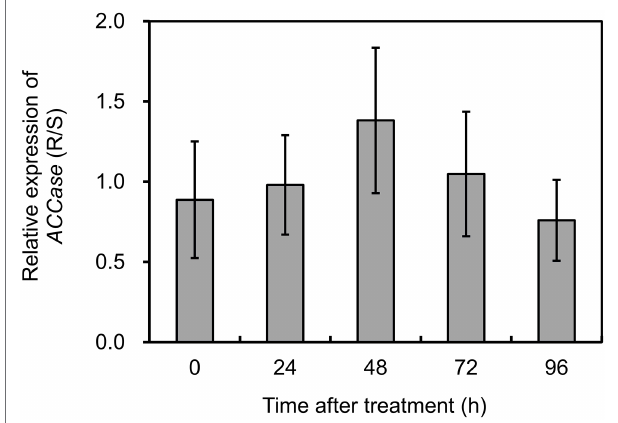
FIGURE 2 | Relative expression levels of ACCase in the R relative to the S plants of Polypogon fugax at 0 (control), 24, 48, 72, and 96 h after fenoxaprop- P -ethyl treatment. Data are the mean values ± SEM.